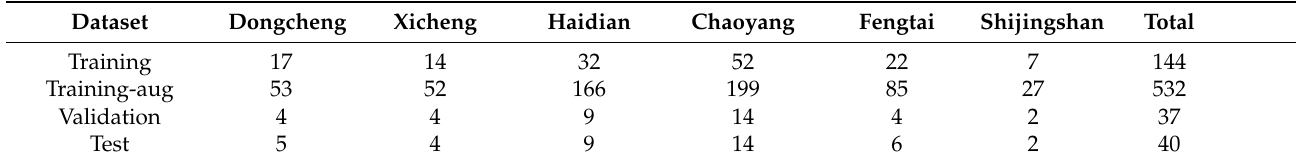
Figure 3. Distribution of samples. These samples are divided into training, validation, and test sets in a ratio of 4:1:1. The data in each set are evenly distributed across districts. The VFSR images with RGB bands come from Google Earth imagery. These images are at a zoom level of 16, with a resolution of 1.8 m for the Beijing dataset and 2.2 m for the Shenzhen dataset. They are cloud free after careful selection, and most of them were taken between July and September of 2015. To expand the dataset, we realized dataset augmenta- tion through adaptively sliding windows with the premise of preserving the park’s integrity as much as possible. The augmented training dataset is abbreviated as “training-aug”. The distribution of samples in these two datasets can be seen in Tables 1 and 2. Table 1. The distribution of samples in Beijing dataset.